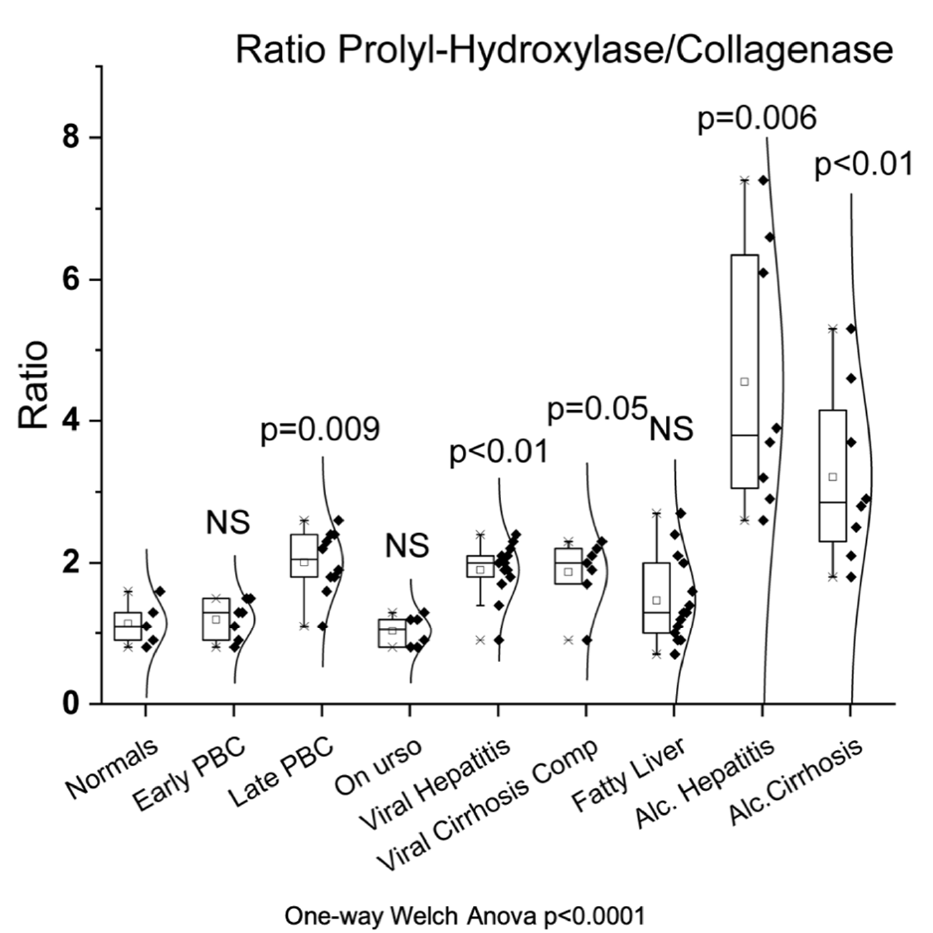
Figure 3. Prolyl hydroxylase/collagenase ratio in all studied groups.